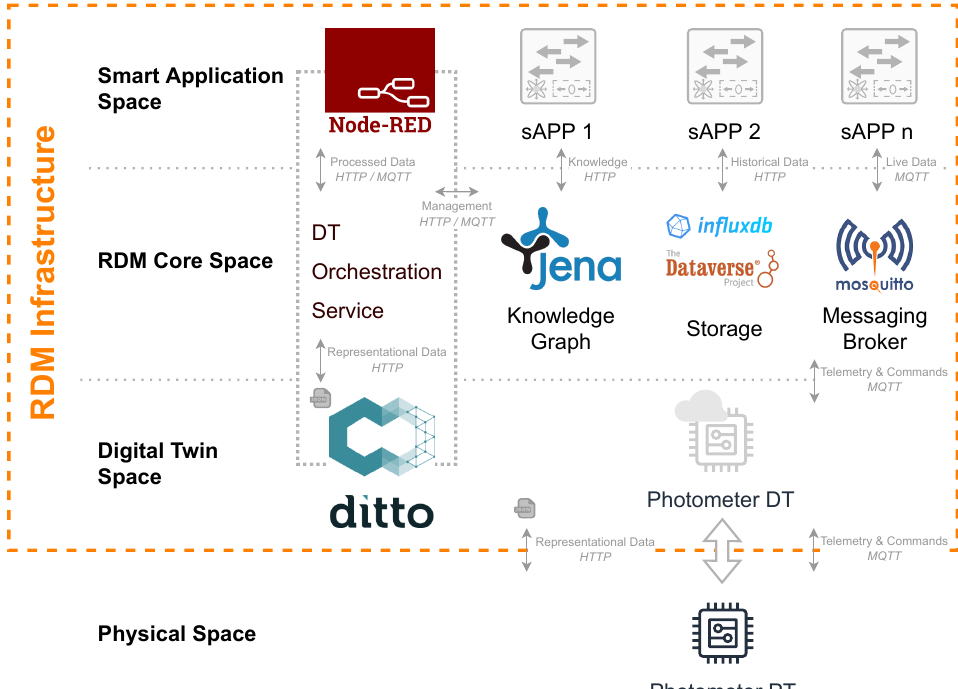
Figure 4. Implementation of the Conceptual RDM